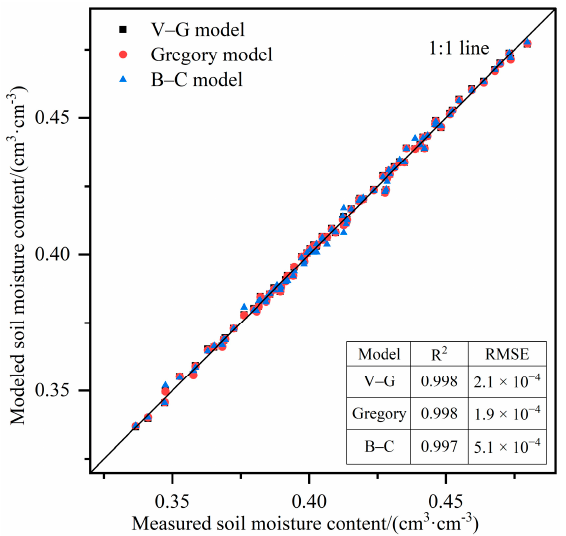
Figure 1. Comparison of modeled soil moisture content and measured soil moisture content. Table 2. Statistical results of soil hydraulics parameters. Soil